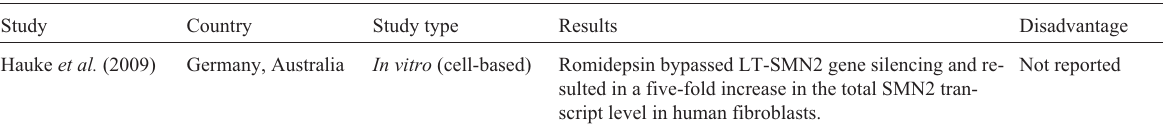
Table 9 - Summary of a study on romidepsin for the treatment of spinal muscular atrophy.